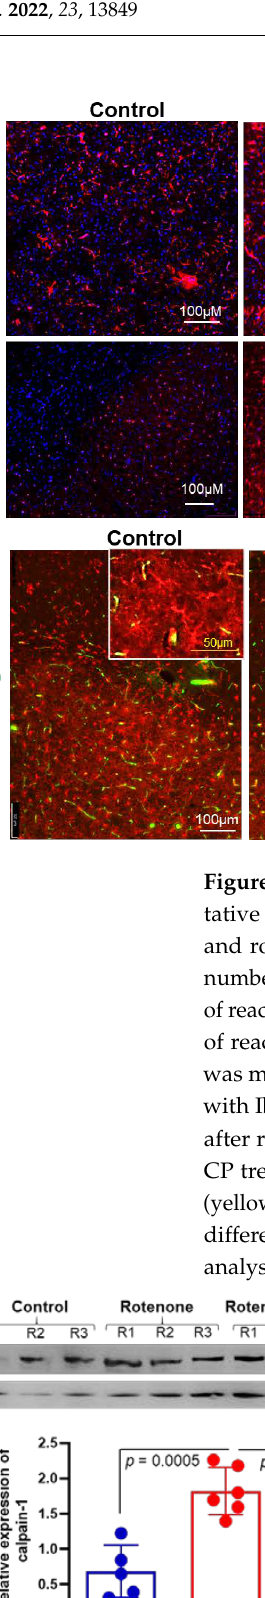
(upper panel). β -actin was used as a loading control. Quantification of the calpain-2 protein level